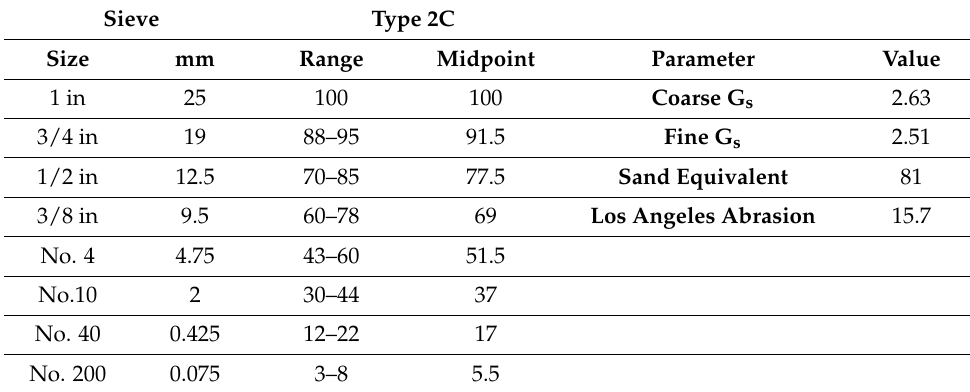
Table 2. Properties of aggregates from southern